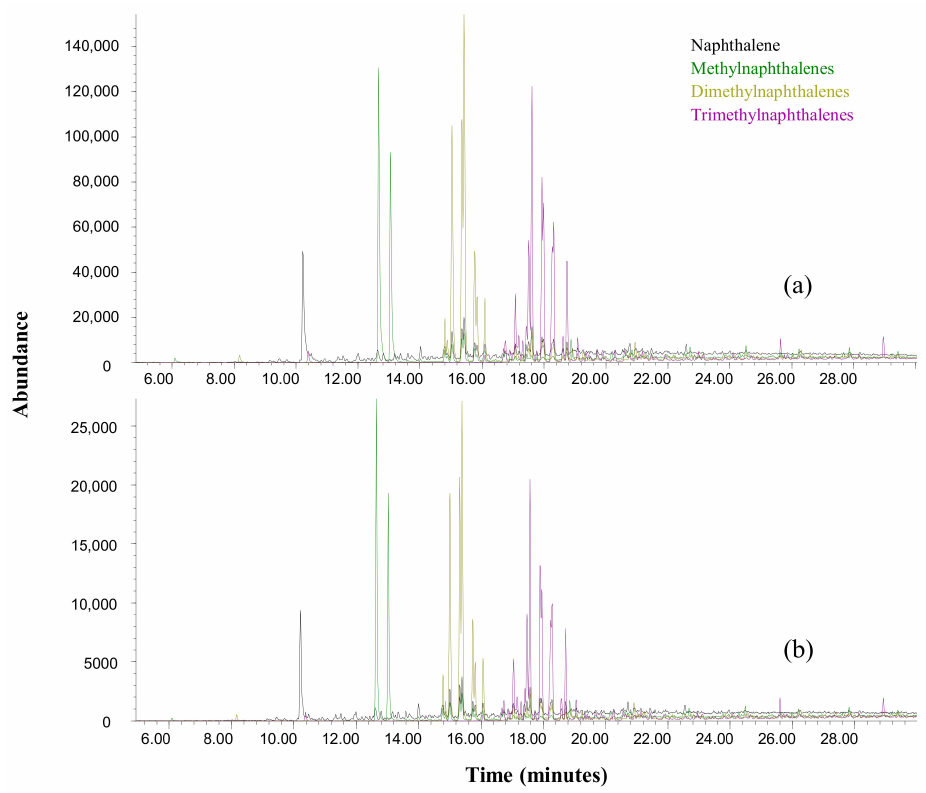
Figure 7. Chromatographic fingerprints of m / z 128, m / z 142, m / z 156, and m / z 170 of ( a ) remaining oil after 120 h in the abiotic test and ( b ) remaining oil after 120 h of Y. lipolytica ’s growth in seawater with 1% v / v of